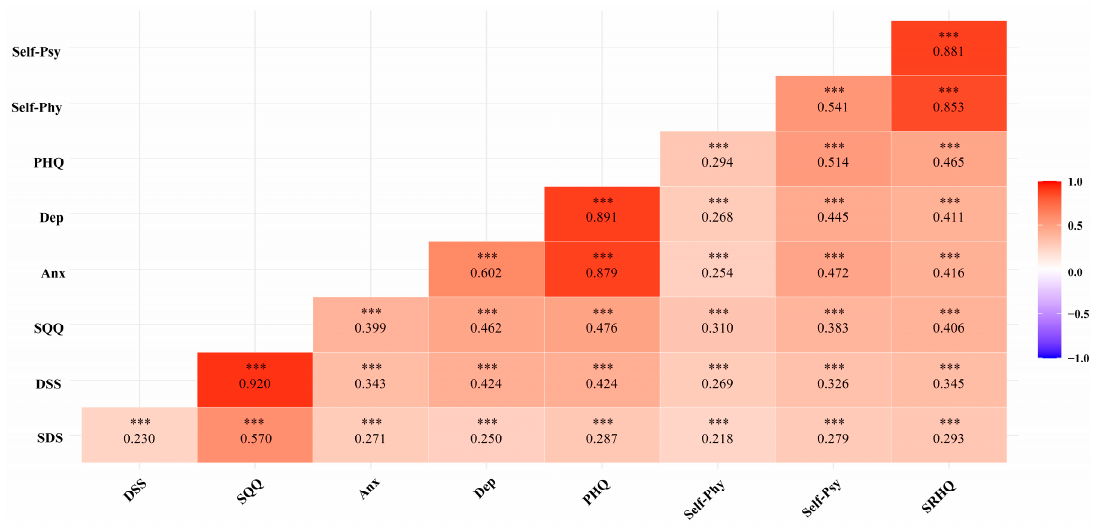
Figure 1. Spearman’s correlation matrix of the SQQ, PHQ, and SRHQ. Note: SDS, Sleep Difficulty Subscale; DSS, Daytime Sleepiness Subscale; SQQ, Sleep Quality Questionnaire; Anx, Anxiety; Dep, Depression; PHQ, Patient Health Questionnaire; Self-Phy, Self-Rated Physical Condition; Self-Psy, Self-Rated Psychological Condition; SRHQ, Self-Rated Health Questionnaire; *** p <